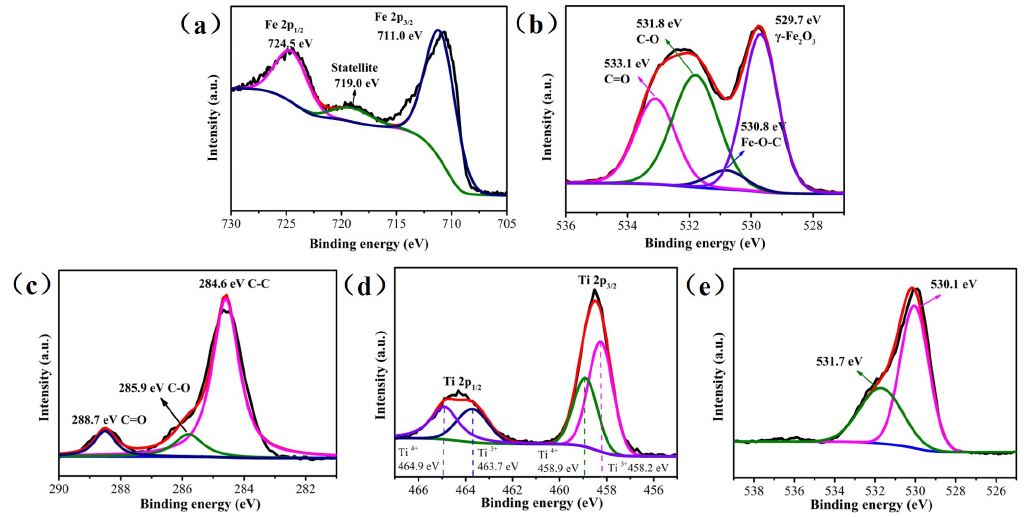
Figure 5. XPS Fe 2p spectrum ( a ), O1s inner shell ( b ), C1s ( c ), Ti2p ( d ), and O1s outer shell ( e ) for non-stacked γ -Fe 2 O 3 /C@TiO 2 .